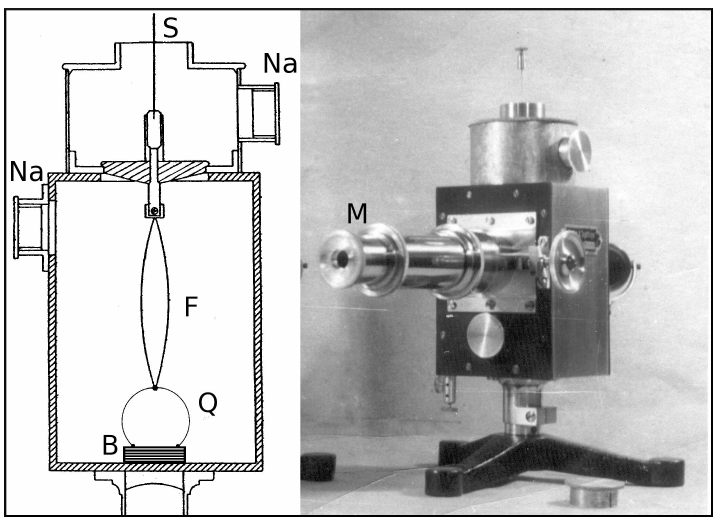
Figure 2. Wulf’s bifilar electrometer (cross section, left). The lower end of metal filaments (F) was fixed to a quartz string (Q), using its elasticity as a repulsive force. The string was mounted on an amber insulator (B). The spread of the filaments was read with a microscope (M). Two openings (Na) could be connected to a sodium-drying device. The complete instrument is shown at right. Wulf received a patent on this device in 1906 (DRP 181284).